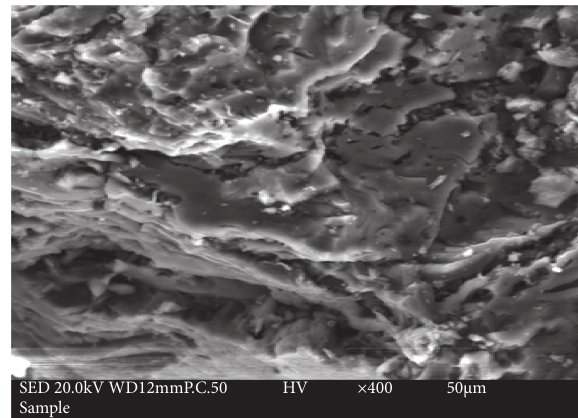
Figure 2: SEM micrographs of AC carbonized at 500 ° C, activated at 500 ° C/2h/2 (g H 3 PO 4 /g